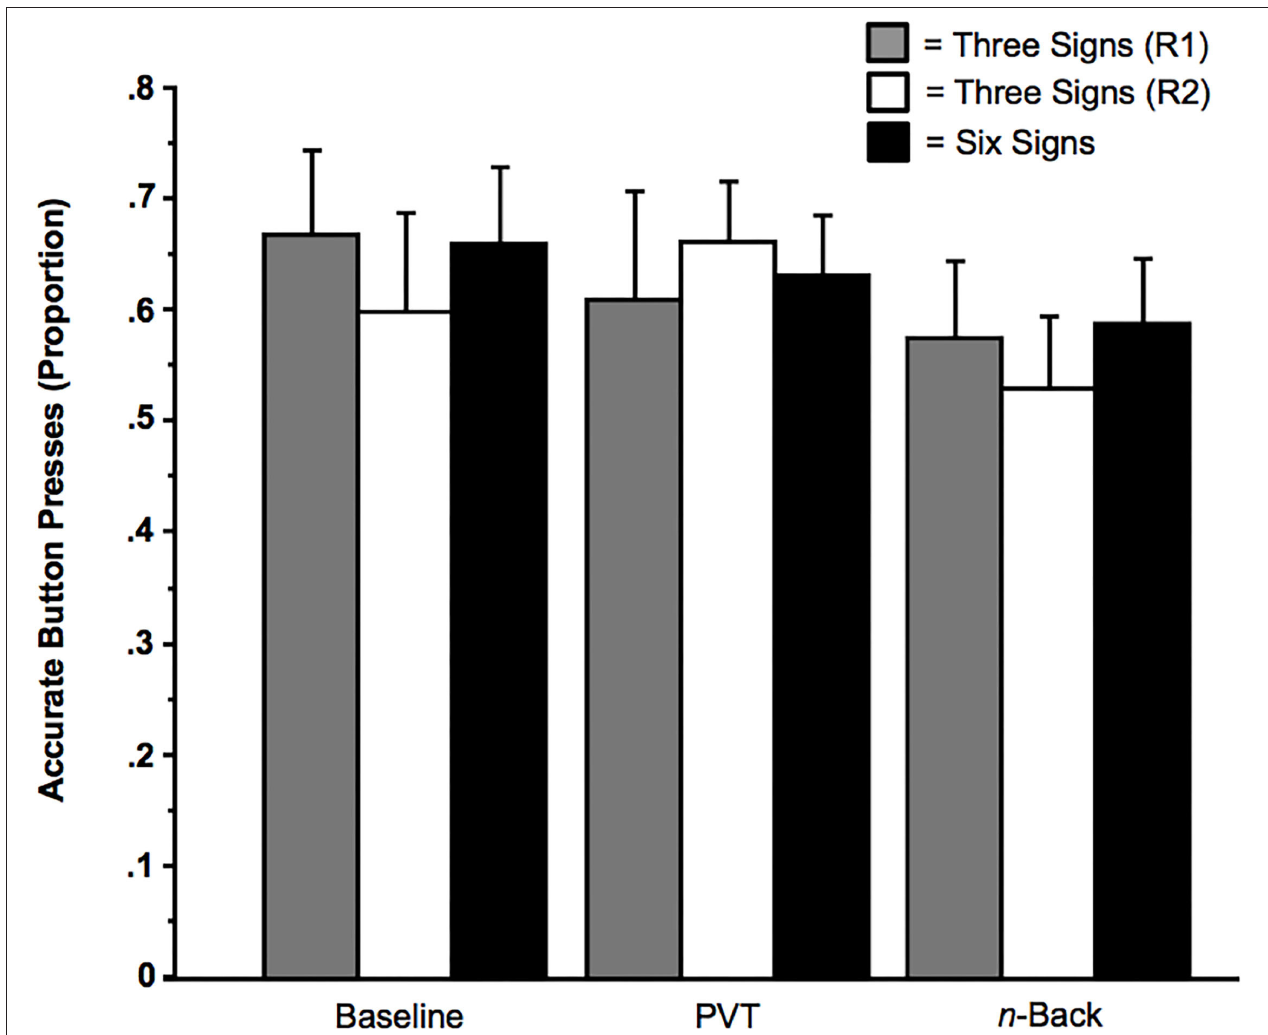
FIGURE 8 | Correct button press to presence of trained sign as a function of Memoranda (three signals or six signals) and Multi-Tasking (None [Baseline], Psychomotor Vigilance Task [PVT], or n -back). The solid black bars indicate subjects who received training for all six signs. The gray bars indicate subjects who received training for the three signs of Bike Lane, Speed Bump, and Fire Truck (Regimen [R1]); the unfilled bars indicate subjects who received training for the signs of Crosswalk, Railroad Crossing, and Ambulance (Regimen 2 [R2]). Error bars indicate SE